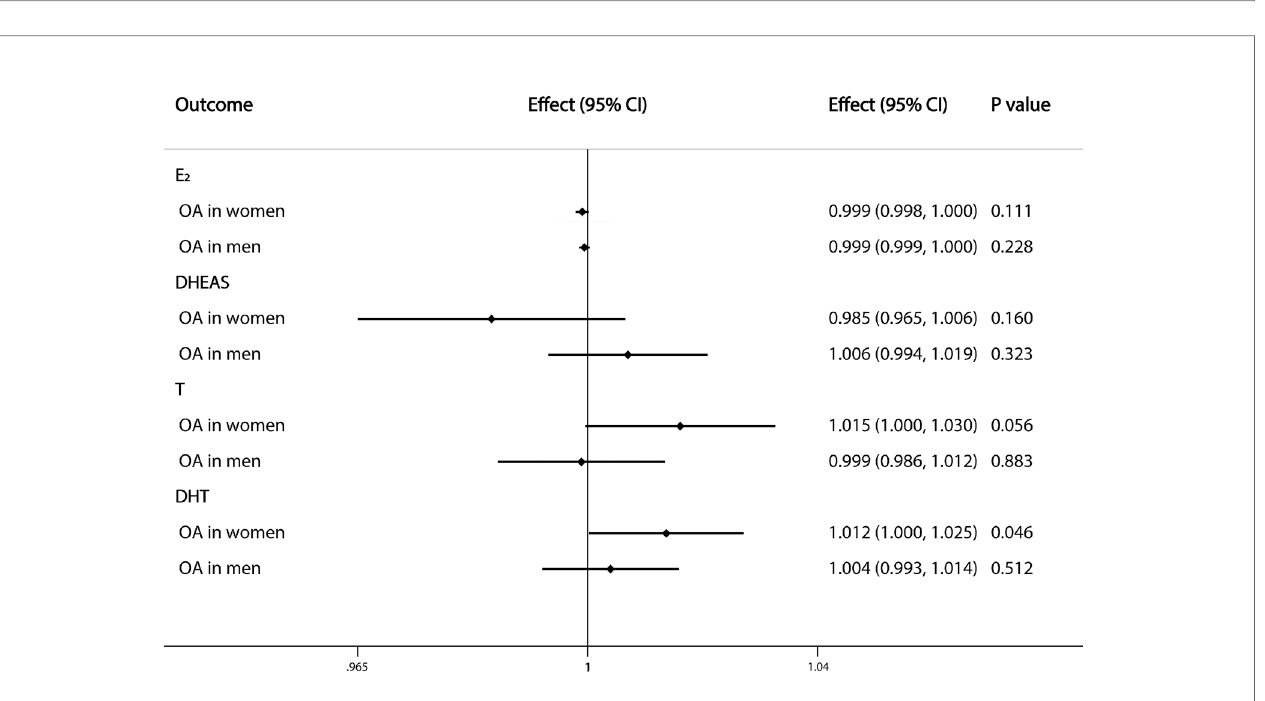
FIGURE 3 | Causal effects of sex steroids on the risk of OA in single sex. The estimated effects, 95% con fi dence intervals and p-values of associations were contained. Effect, the combined causal effect; CI, con fi dence interval; P value, p-value of the causal estimate.